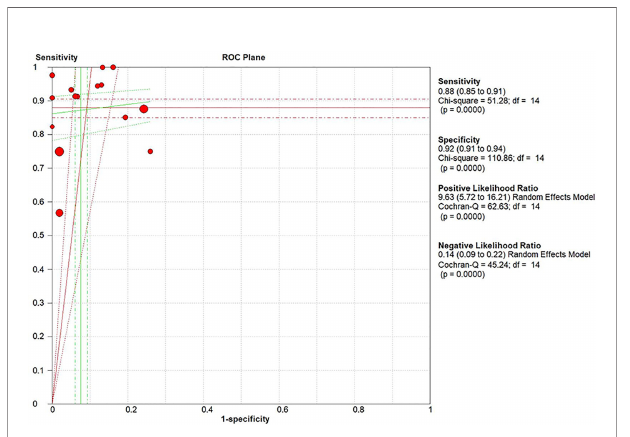
FIGURE 6 | Summary of the pooled ROC plane.